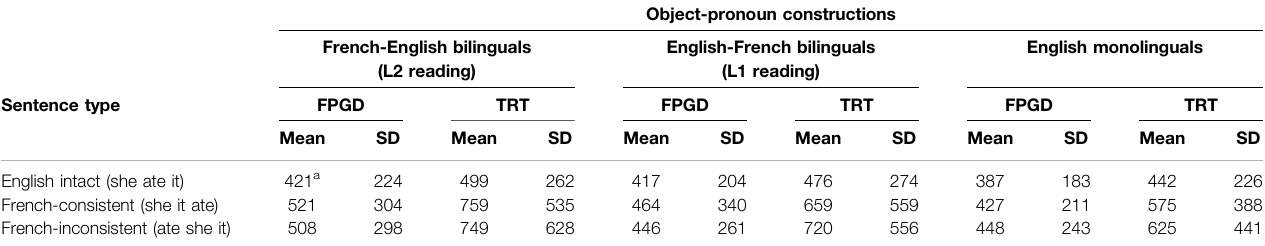
TABLE 3 | Descriptive statistics for all dependent measures of object-pronoun constructions for Experiment 1 (left), Experiment 2 (center) and Experiment 3 (right).